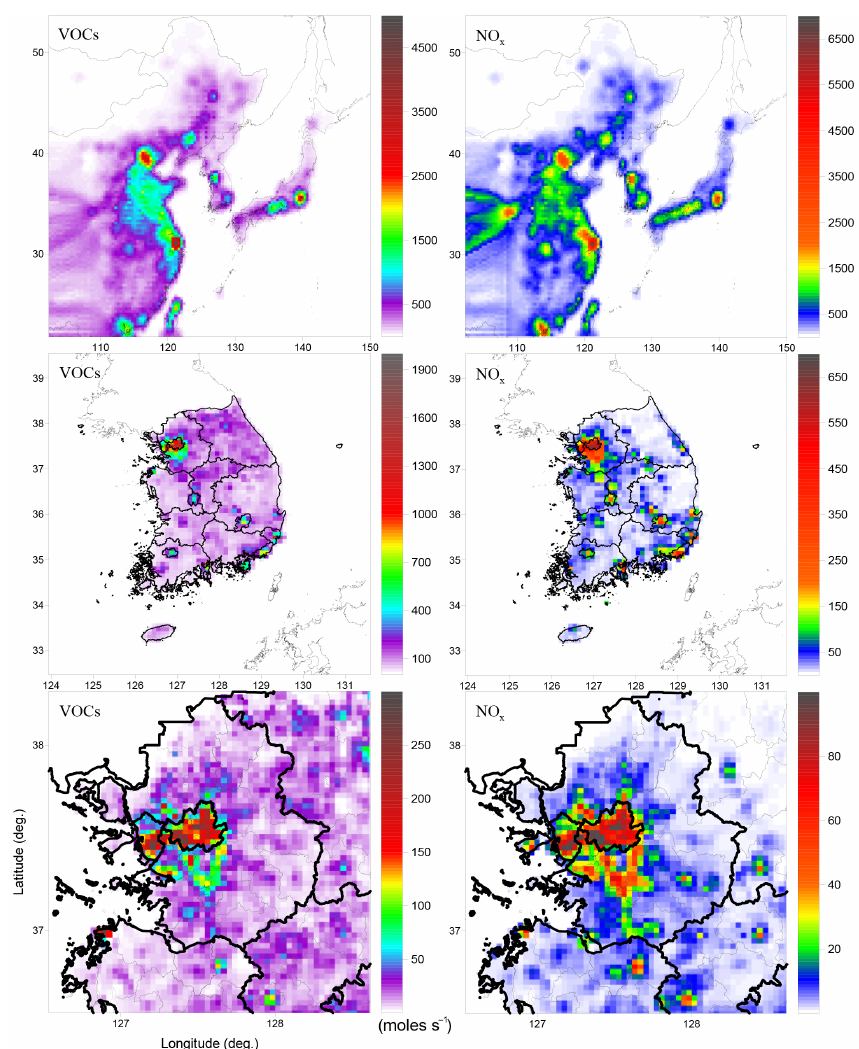
Figure 2. Horizontal distributions of emission rate for domain d27 (top), d09 (middle), and d03 (bottom). The left and right panels are for VOCs and NO x emission rates,